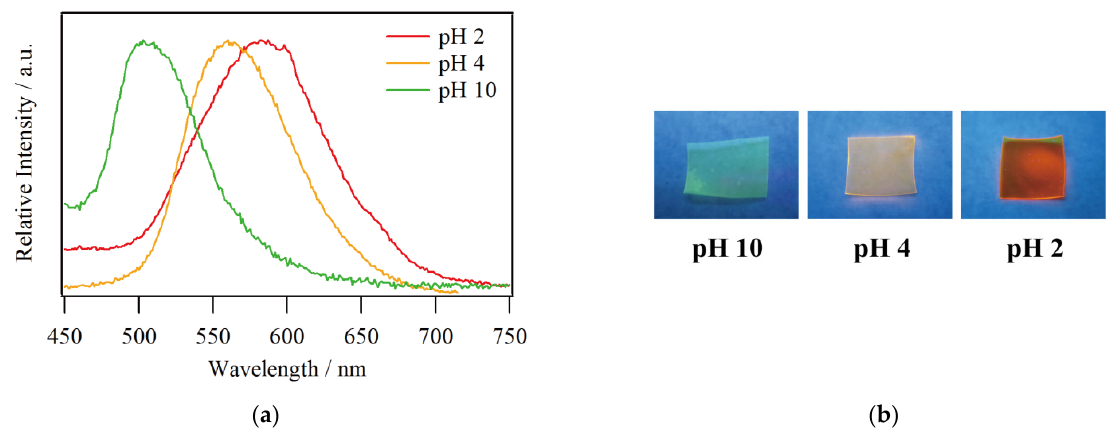
Figure 4. ( a ) Emission spectra and ( b ) photographs of 1 @Nafion at pH 2, 4, and 10 under UV irradiation ( λ ex = 365 nm).